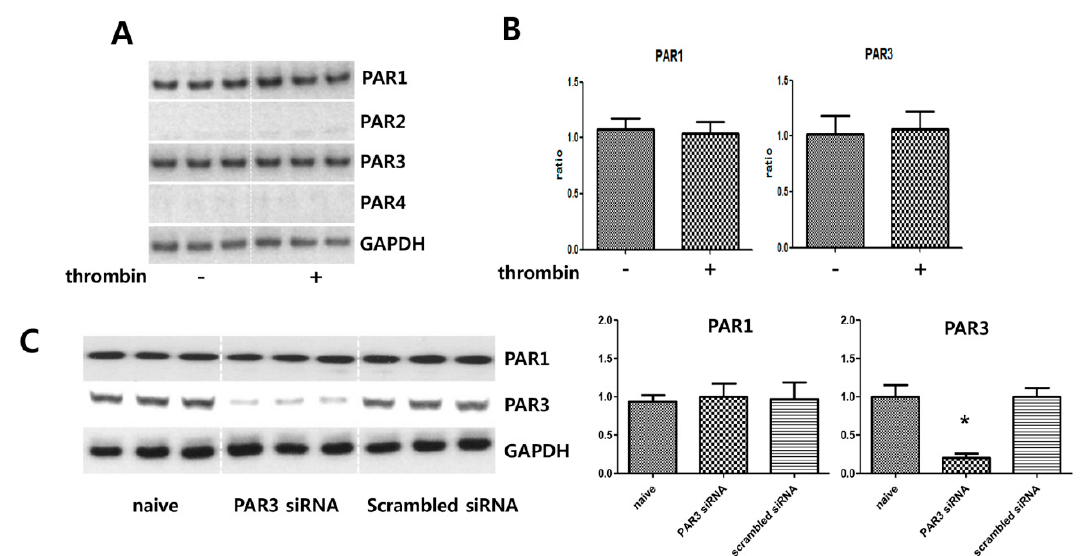
Figure 2. Expression of protease-activated receptors. After thrombin preconditioning (2 U) for 6 h, umbilical cord-derived mesenchymal stem cells (UCB-MSCs) were lysed and subjected to immunoblotting analysis with the indicated antibodies. ( A ) Immunoblot analysis of the expression of protease-activated receptors (PARs) in UCB-MSCs. After thrombin preconditioning, the levels of PARs in the UCB-MSCs were determined by immunoblotting analysis. ( B ) Bar graph showing quantification of the amounts of each PAR. ( C ) Lysates from UCB-MSCs treated with the indicated siRNAs for 24 h were subjected to immunoblot analysis. Cell lysates were analyzed by immunoblotting, and the protein levels were normalized to GAPDH. An asterisk (*) indicates a significant difference vs. naive EVs.